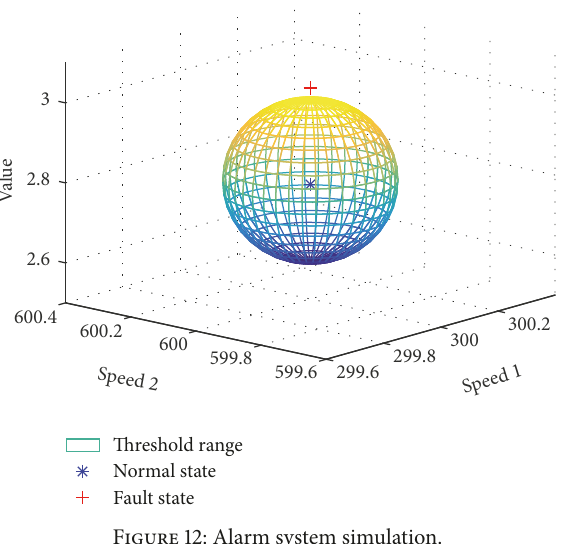
Figure 12: Alarm system